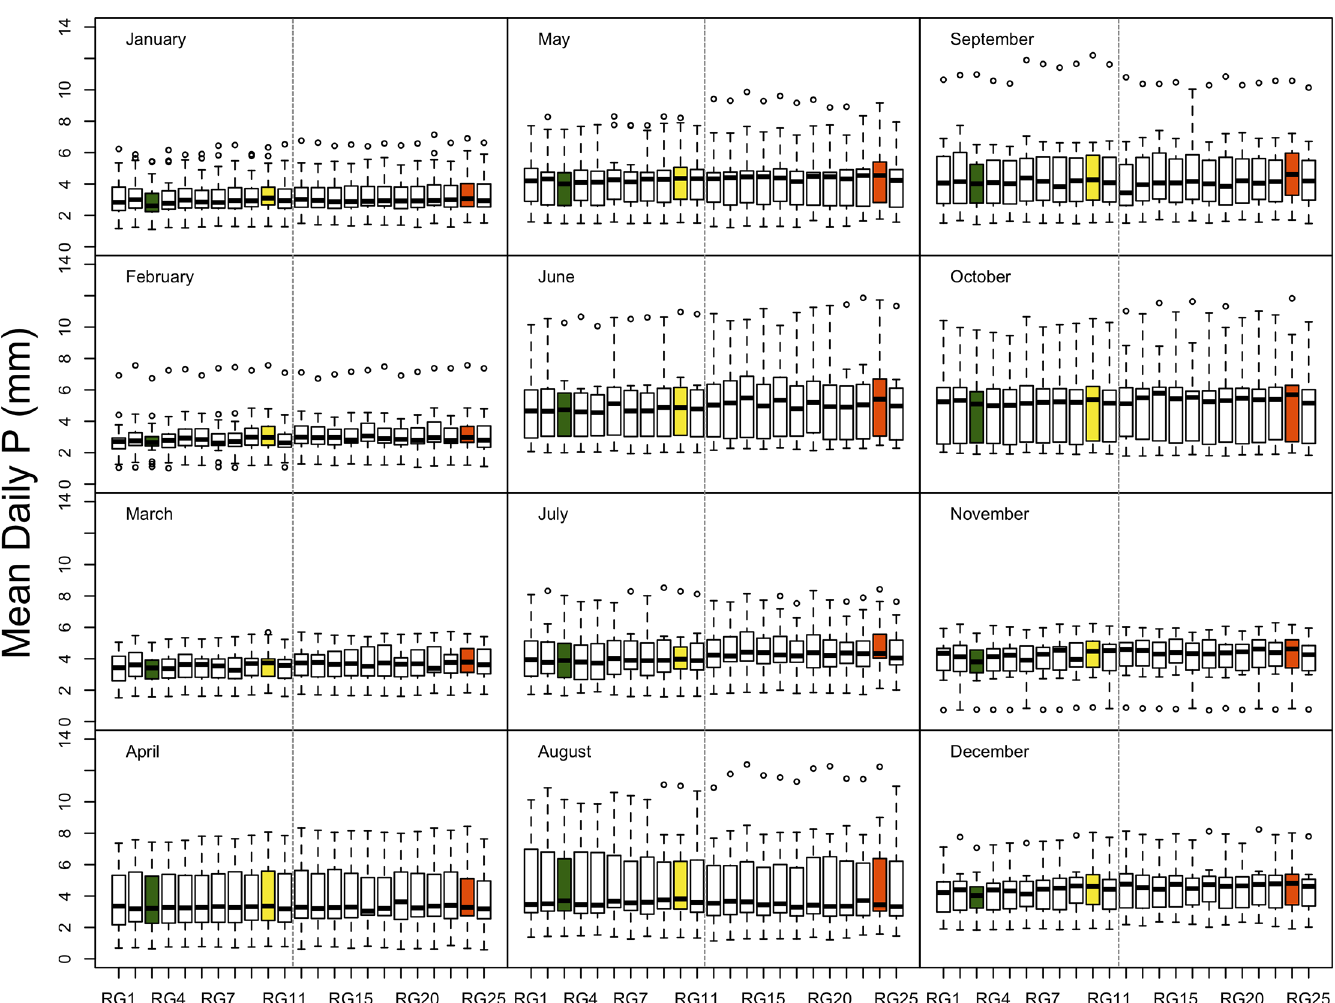
Fig 2. Boxplots of monthly precipitation (mm day -1 ) for the 1998 to 2014 period. Boxes extend from the 1 st to the 3 rd quartile and the line shows the median. The whisker extends up to 1.5 times the and interquarile range (IQR) from the box or to the most extreme value. Open circles indicate values more than 1.5 times the IQR from the box. Vertical dashed lines separate the north and south facing gauges. Colored boxes highlight gauges discussed in the text, with colors corresponding to Fig